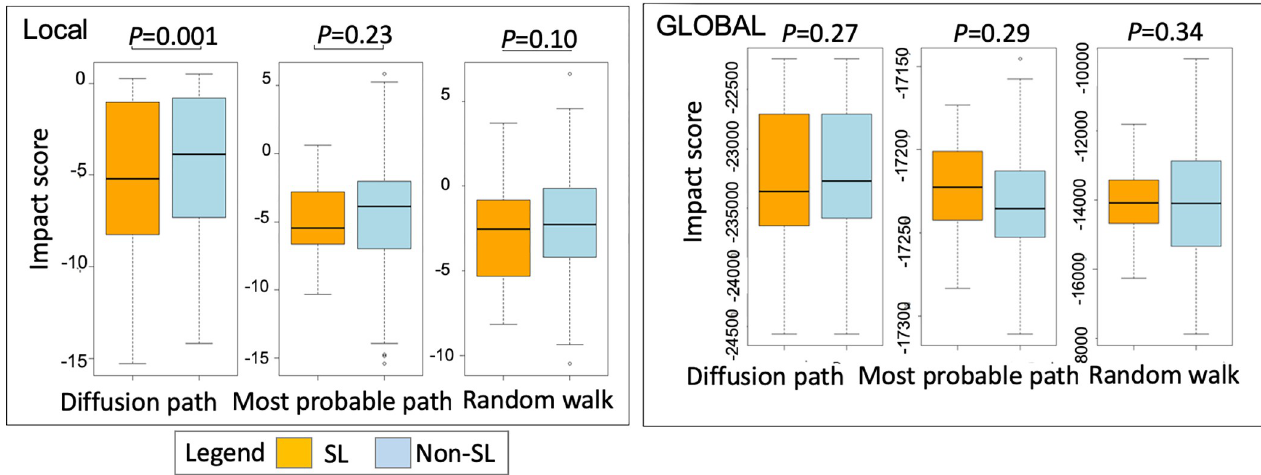
Fig 4. Comparison of target-combination impact scores using synthetic versus non-synthetic lethal gene pairs in pancreatic cancer. The three methods for calculating target impact score–the most-probable, random-walk, and diffusion paths are defined in Fig 2 . The target impact scores (IS) are calculated from either the global protein-protein interaction (PPI) network (global) or the local PPI network (local).